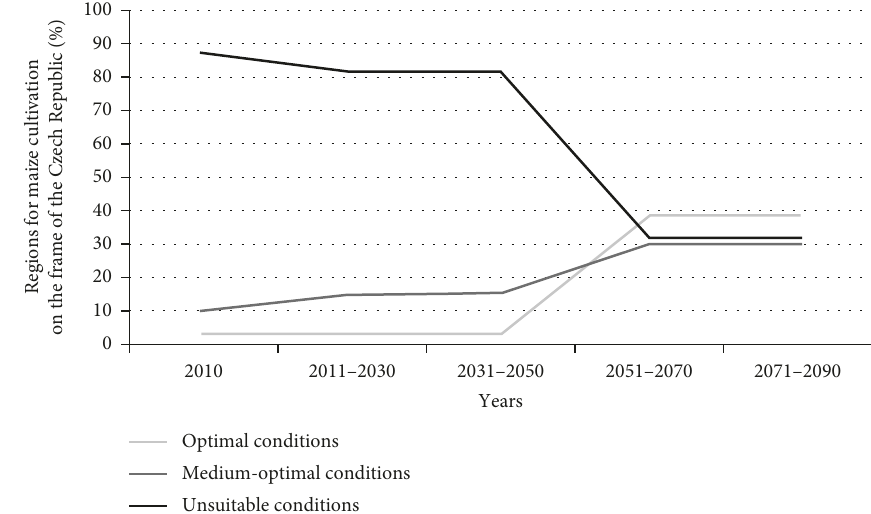
Figure 7: Relative time changes in areas with different climate conditions for grain maize growing in the study region of the Czech Republic based on the regional biogeographical